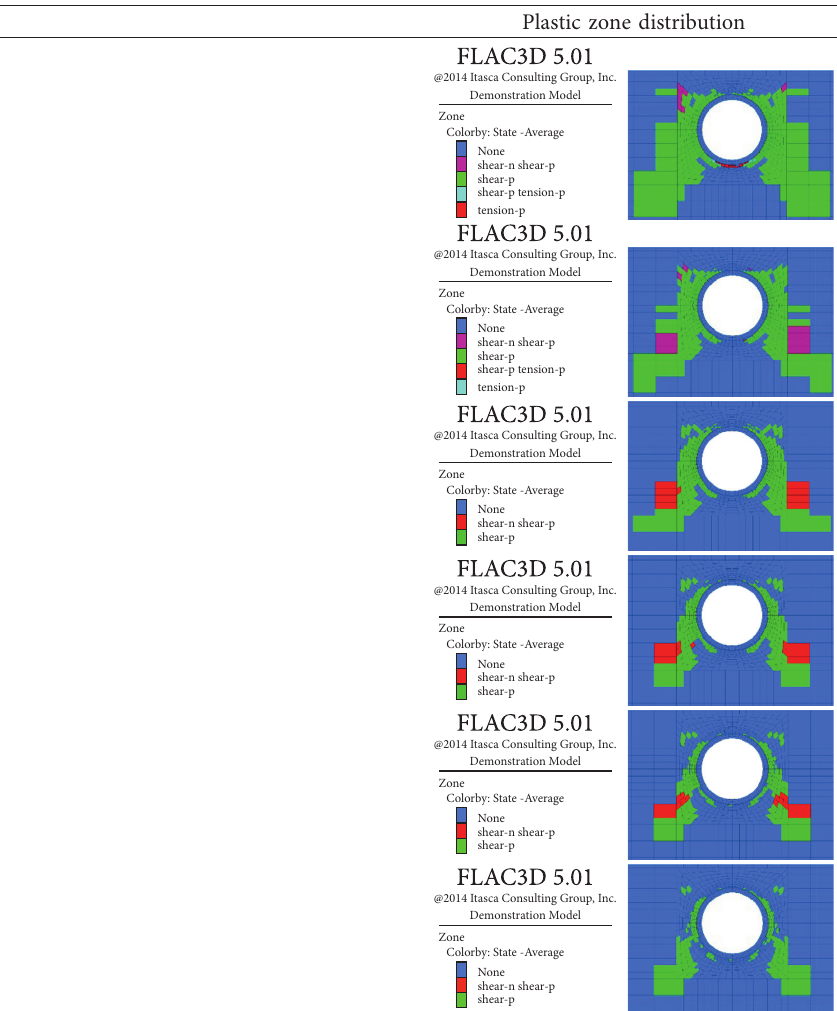
Figure 8: Variation of segment convergence under different grouting pressures. Table 12: Distribution of plastic zone under different grouting